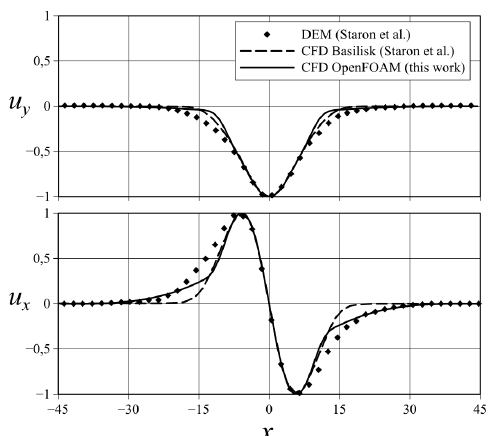
Figure 3. Velocity profiles: horizontal component (left) and ver- tical component (right) at y = 0 . 15